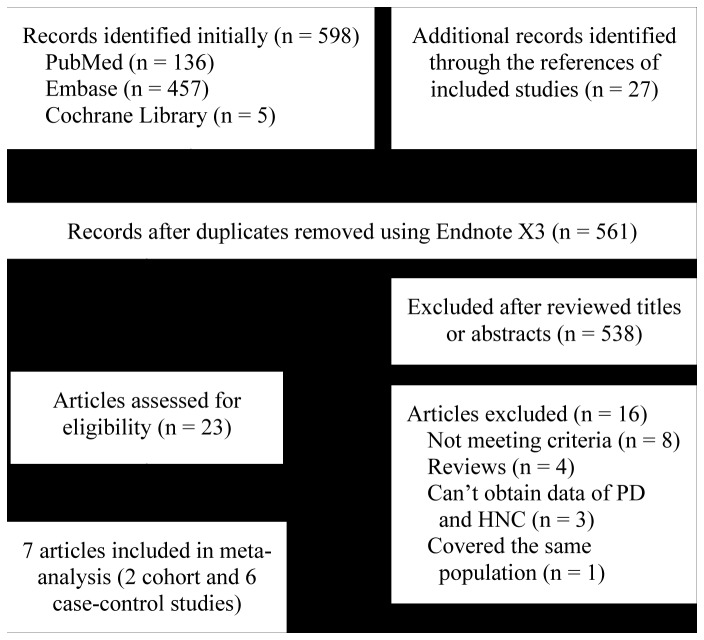
Flow chart from identification of eligible studies to final inclusion.PD, periodontal disease; HNC, head and neck cancer.